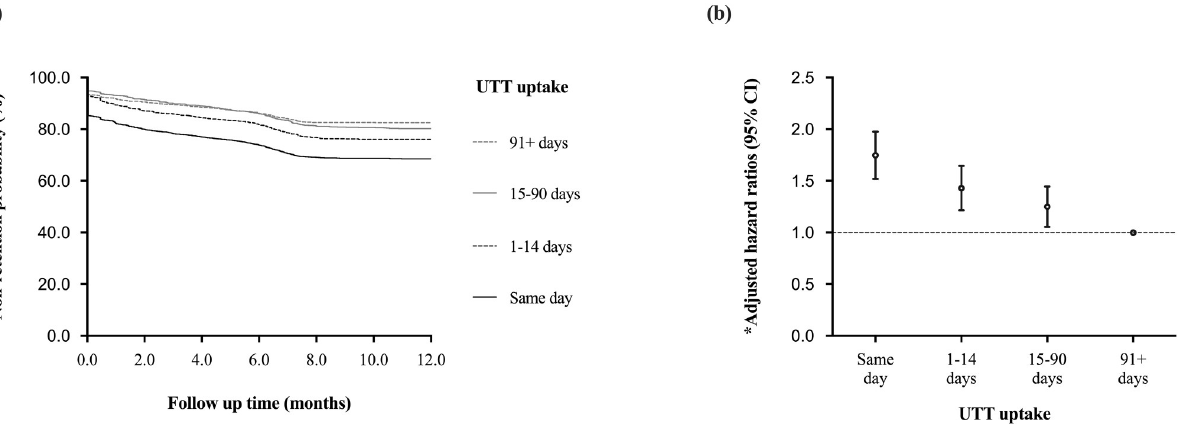
Fig 3. Kaplan Meier survival curve illustrating twelve months non-retention, defined as lost to follow up or dead, among of HIV infected adults by uptake of universal test and treat, defined as same day, 1–14 days, 15–90 days and 91+ days from a HIV diagnosis to combination antiretroviral therapy start, using data from the national data warehouse in Kenya (2015HY2 to 2018HY1, N =